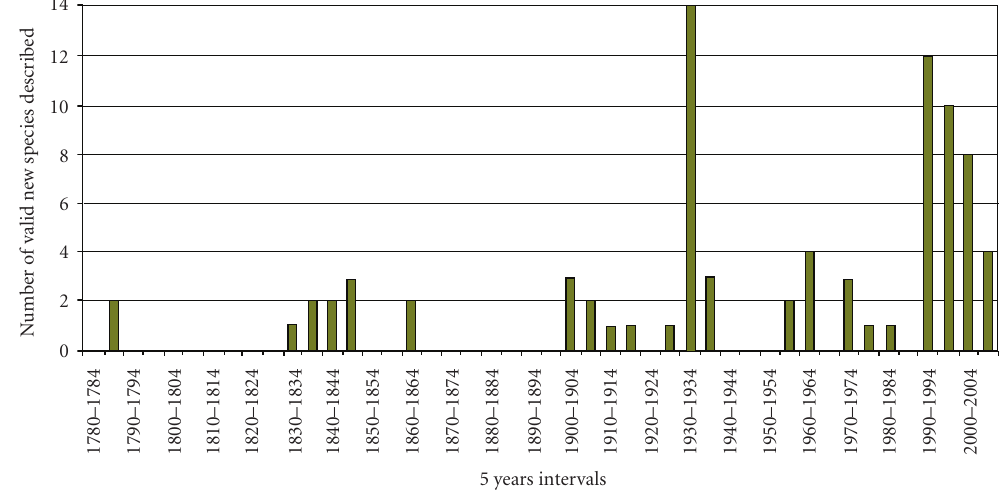
Figure 3: Progress in alpha-level taxonomy of North American Panorpa , 1780–2009. Since 1958, new species have been discovered at a rate of approximately nine every ten